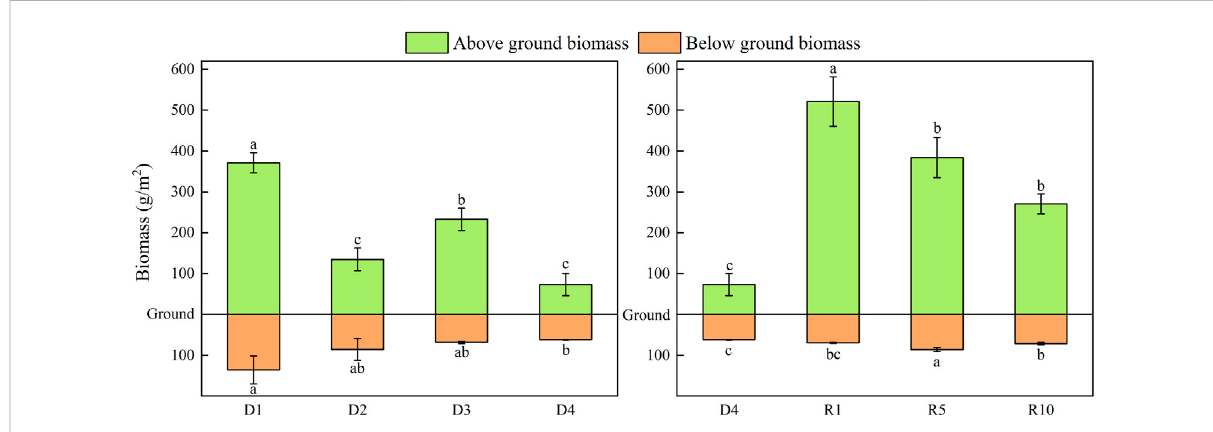
FIGURE 2 Changes in plant biomass at different stages of degradation and at different recovery